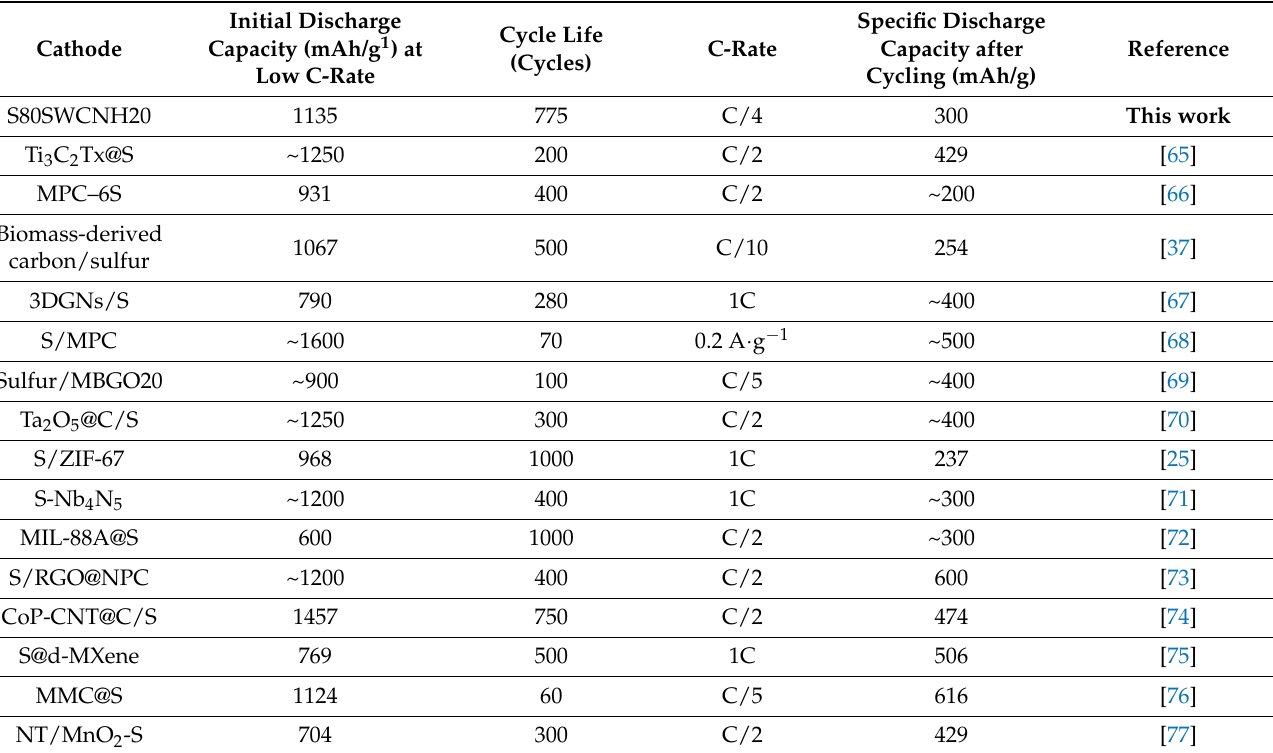
Table 1. Comparison of the main electrochemical criteria of some recently published papers regarding sulfur composite cathode in lithium–sulfur